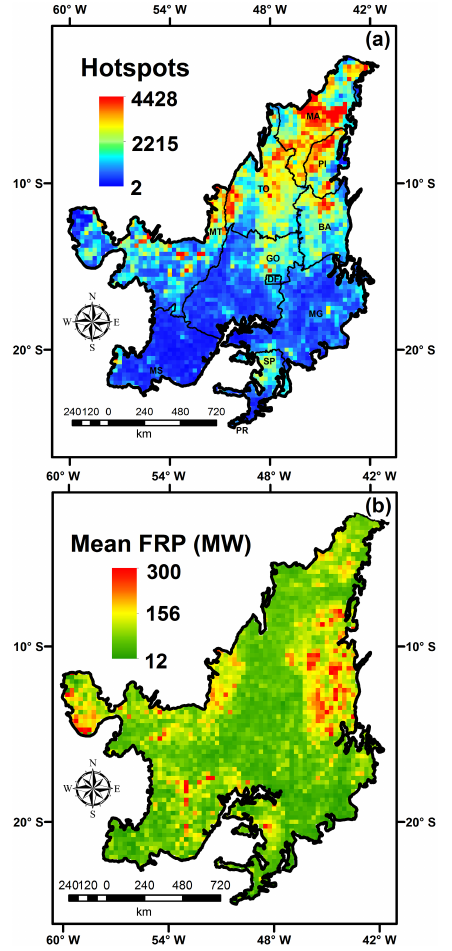
Figure 3. (a) Total of hotspots and (b) mean FRP detected by the MODIS active fire products in the Cerrado biome between 2002 and